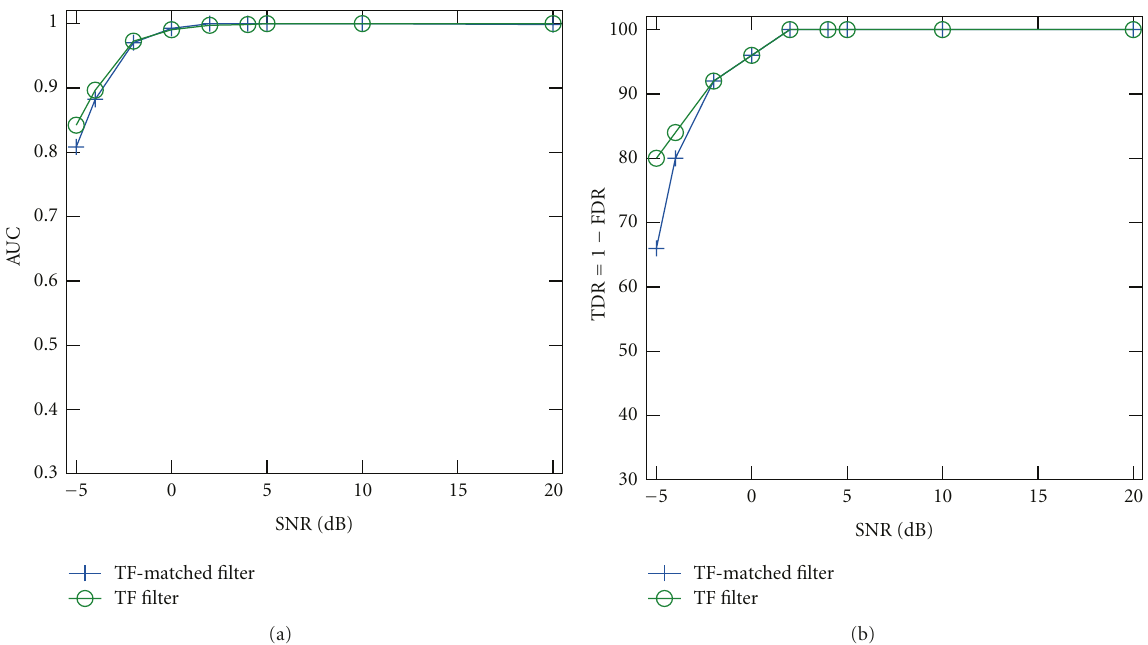
Figure 12: Detection results for time-frequency filter method and time-domain-matched filter in white Gaussian noise with low-energy